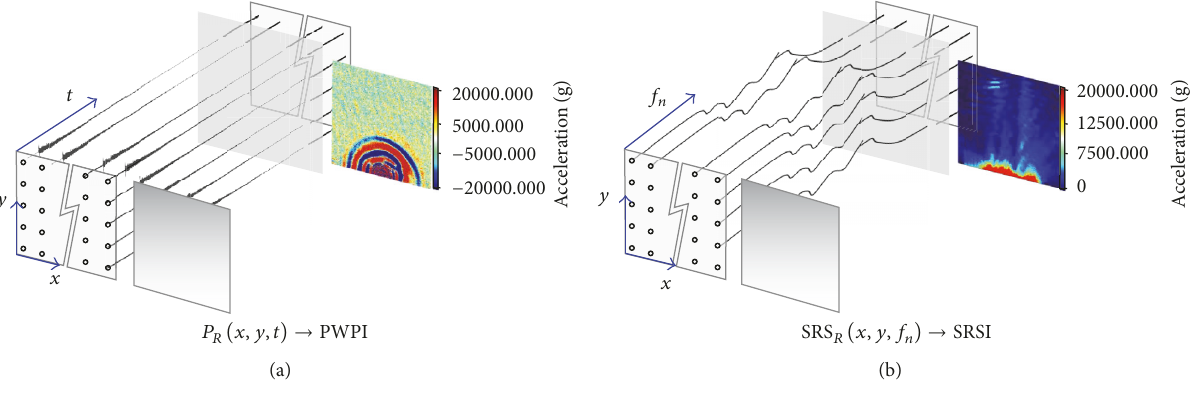
Figure 8: Pyroshock propagation evaluation; (a) PWPI; (b) SRSI.